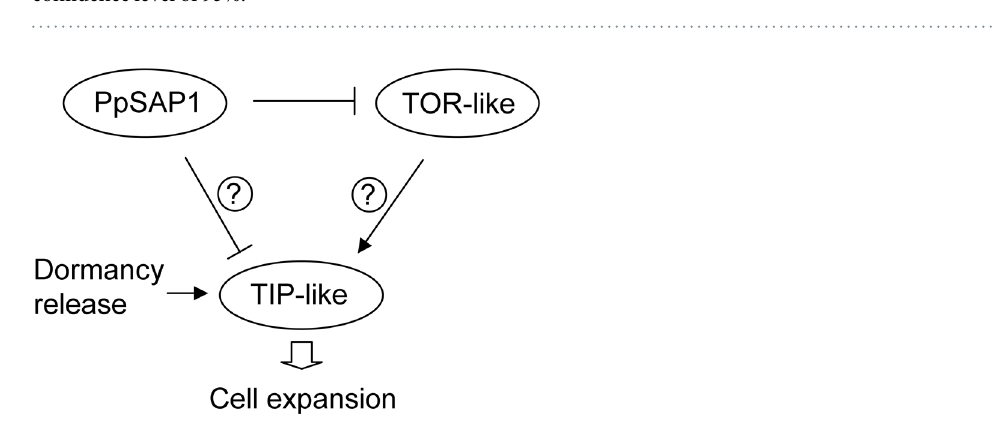
peach leaves under drought stress, leaves gathered from three different trees of cv. ‘Red Candem’ were collected on 27 April 2015. Finally, for leaf discs assays, leaves from five different trees of cv. ‘Big Top’ were collected on 9 June 2015. The culture chamber was maintained at 24 °C with 12 h:12 h light (3 klx):dark photoperiod. Stress treatments.